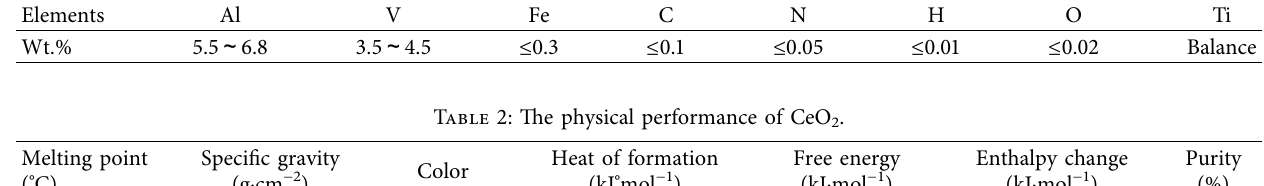
Melting point ( ° C)